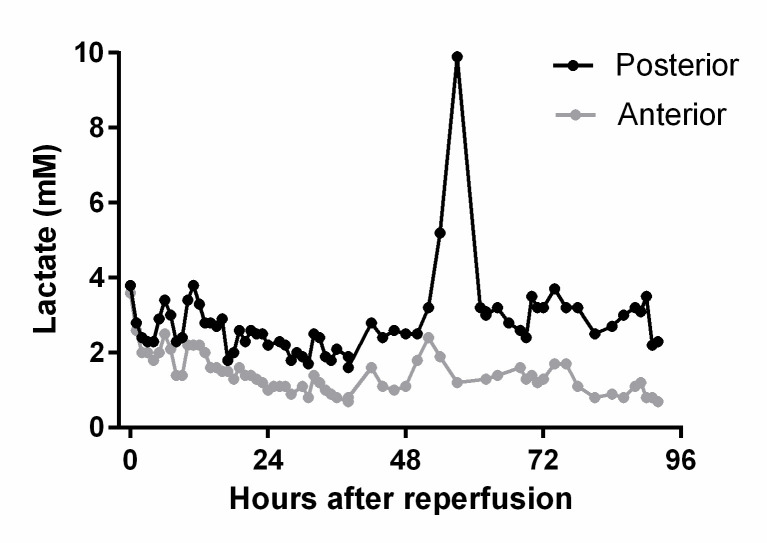
Microdialysis lactate elevation.Lactate concentration in a pancreas graft with venous thrombus, measured in microdialysate sampled posterior and ventral to the transplanted pancreas. Notice the peak in the posterior lactate level, followed by a rapid fall after circulation was re-established by thrombus extraction.